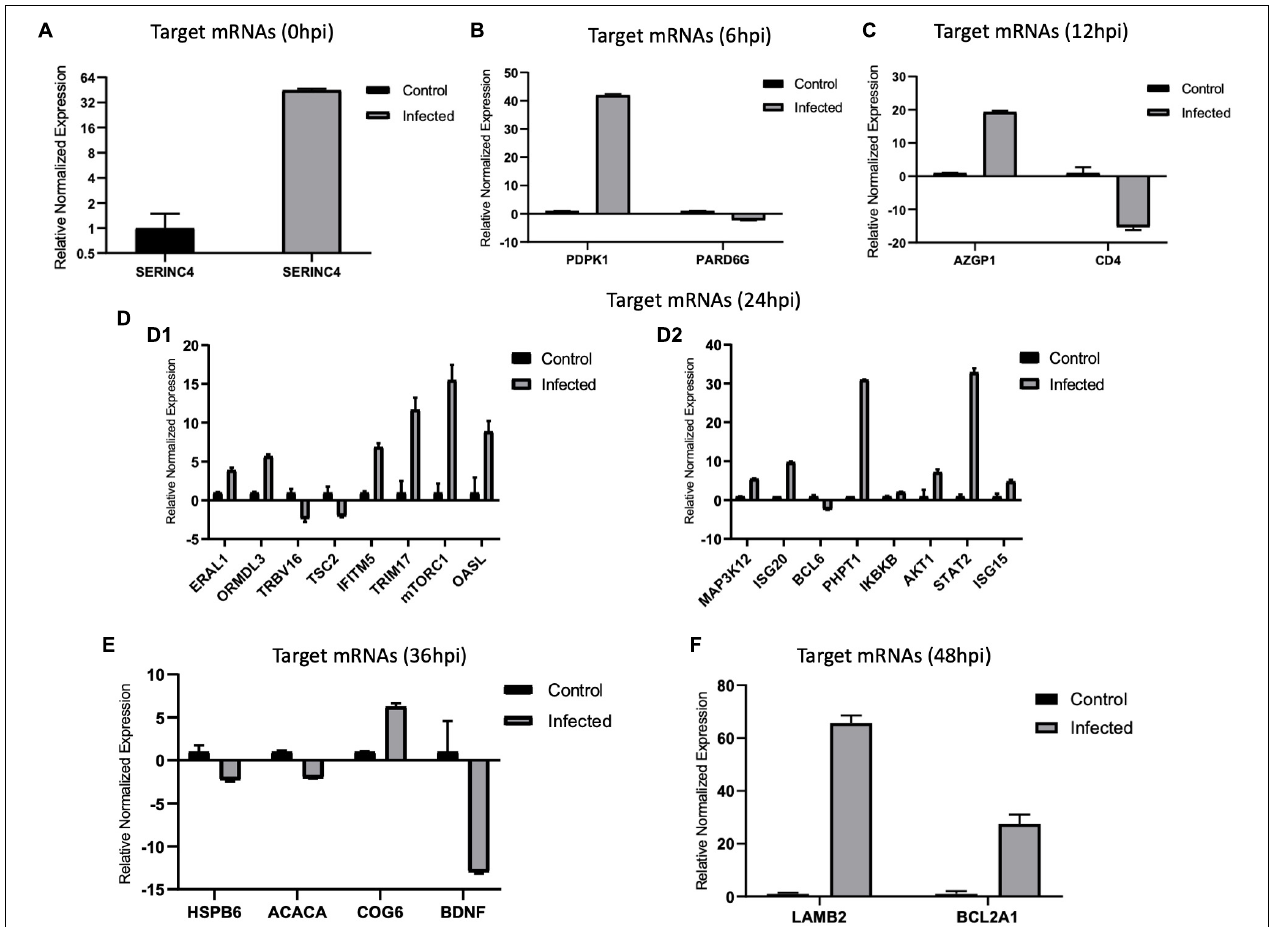
FIGURE 8 | (A–F) Validation of target messenger RNAs (mRNAs) by real-time quantitative PCR (qPCR) from 0 to 48 hpi. The differences in expression were determined using the 2 - (cid:49)(cid:49) CT method and with unpaired, two-tailed Student’s t -test for grouped data. All experiments were performed in triplicate ( n = 3). β -actin was used as an internal reference. Data represent the mean ± SD ( error bar ). Significant difference thresholds: log2(fold change) > 2 and of FDR-adjusted p < 0.05.